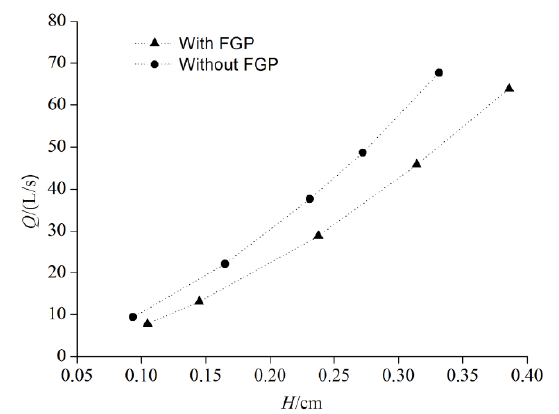
Figure 6. Head–discharge relationship of the weir for the cases with FGP ( β = 0.51, θ = 15 ◦ ) and without FGP.